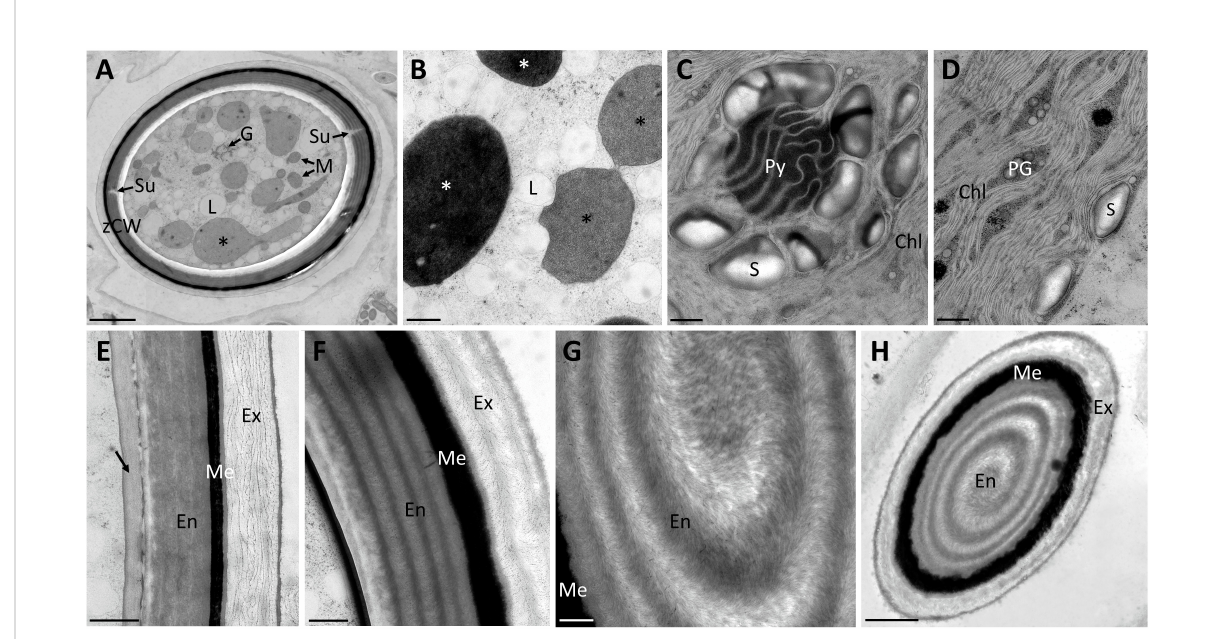
FIGURE 2 Transmission electron micrographs of high pressure frozen/freeze substituted Spirogyra sp. zygospores. (A) overview of zygospore with visible sutures and medium electron-dense compartments (black asterisks); (B) lipid accumulation in the cell lumen and medium electron-dense (black asterisks) and electron-dense (white asterisks) compartments; (C) detail view of pyrenoid surrounded by starch grains and chloroplast lobes; (D) chloroplast lobes with plastoglobules; (E) zygospore wall, displaying an additional layer with a medium electron density (arrow) and a loose structure of the exospore; (F) zygospore wall with distinct helicoidal orientation of the micro fi brils in the endo- and exospore; (G) detail view of the micro fi bril arrangement in the endospore; (H) tangential section through zygospore, displaying a helicoidal arrangement of the micro fi bril bands in the endospore. Chl chloroplast lobes; En Endospore; Ex exospore; G Golgi bodies; L lipid body; M mitochondria; Me mesospore; PG plastoglobules; Py pyrenoid; S starch; Su suture; zCW zygospore cell wall. Scale bars: (A, H) 2.5 µm; (B – G)